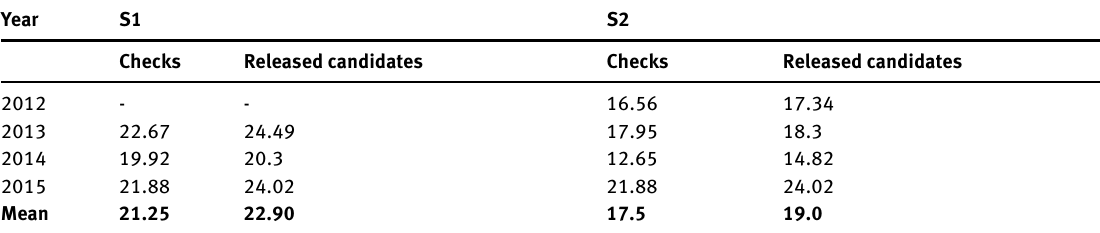
Figure 2 : Mean tuber yield of the candidate varieties and the checks Table 1: Tuber yield of released candidate varieties and the checks